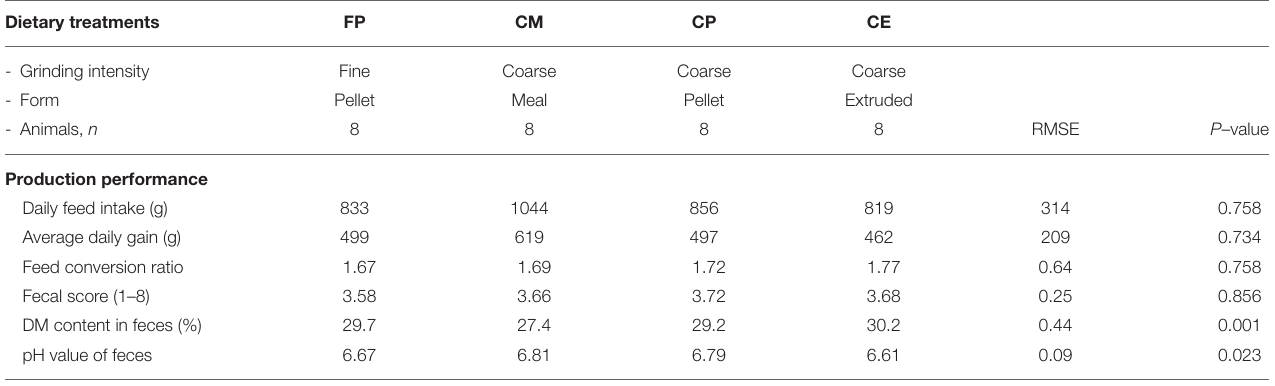
CP coarse, pellet